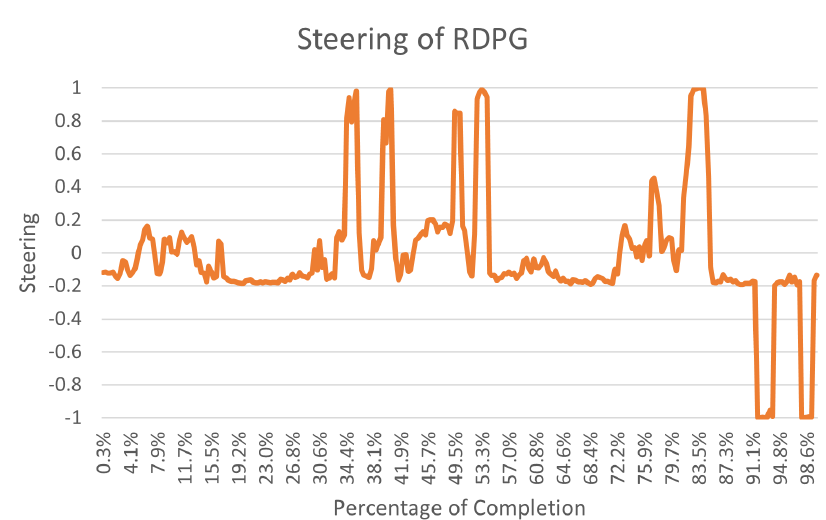
Figure 17. The speed data of the DDPG.